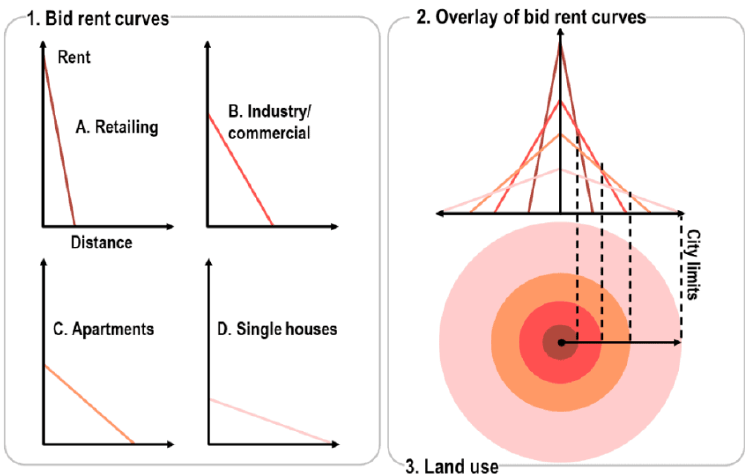
Figure 1. Land rent and land use: overlapping bid rent curves of all urban economic activities for a concentric land use pattern, consisting of retail in the CBD, industry/commercial areas in the next ring, apartments in the next, and then single houses in the next, according to Rodrigue et al., 2013. The land use model application varies depending on the age, size, and locational set- ting of the city. Concentric cities are smaller and older, while polycentric cities are larger and trending in urban development [21,22]. The urban land rent and land use models that are applied in the developed world may represent cities in the developing world such as Sub-Saharan Africa, where an informal landscape of shantytowns represents a land use structure that is not effectively captured by conventional land use models [1].